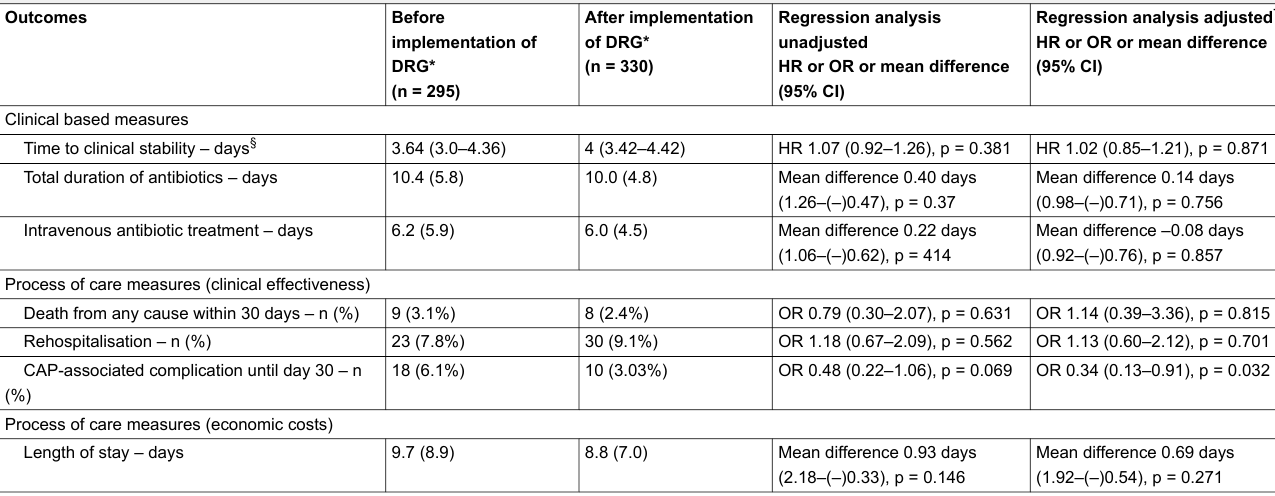
Table 4: Patient outcomes according to time of implementation of reimbursement based on drug-related groups. Outcomes Before